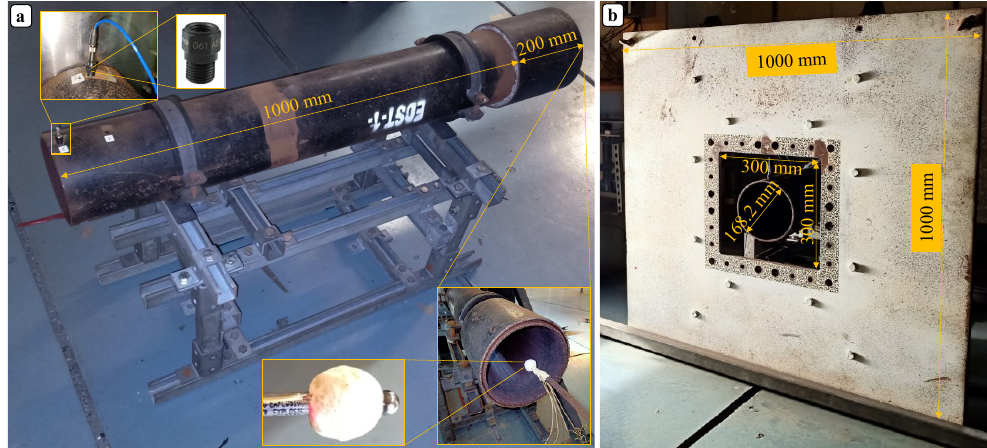
Figure 1. ( a ) EDST mounted on its controllable steel structure showing: (i) the placement of the C4 charge with the steel ball bearing at the tube’s entrance, (ii) the high-frequency pressure sensor at the exit of the tube, ( b ) steel frame placed at the exit of the EDST to allow for the measurement of pressure, velocity, and arrival